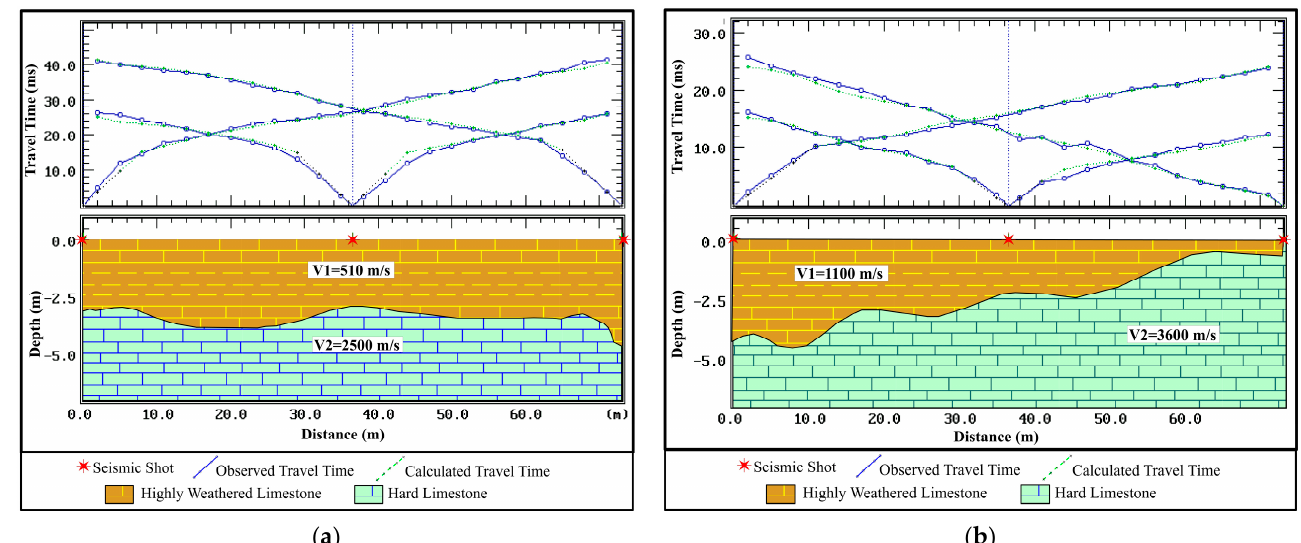
Figure 8. Travel time curves and calculated velocity–depth model of seismic refraction profiles that describe in its upper part both observed and calculated travel time curves and on its lower part the calculated depth–velocity model. The good agreement between the observed and calculated travel times indicates the integrity of the calculated depth–velocity models of the profiles ( a ) SR#1 and ( b ) SR#15.